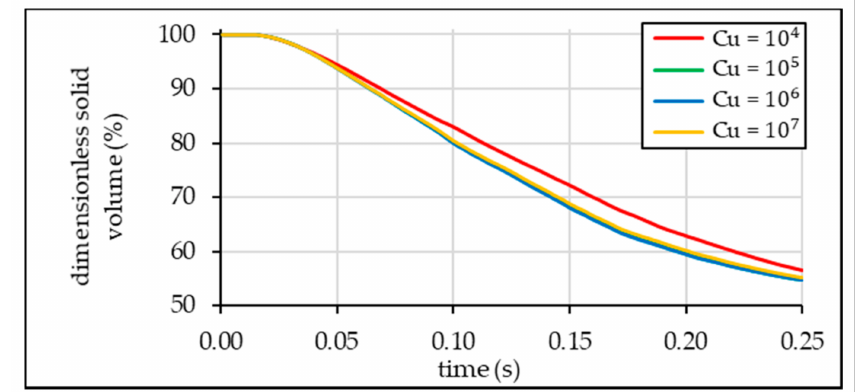
Figure 15. Dimensionless solid volume evolution through time (Extra Fine mesh).